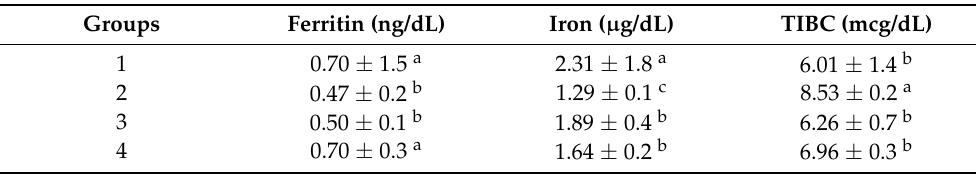
Table 1. Iron profile in lead-acetate-induced anemic rats treated with chemical or green biosynthe- sized magnetic iron oxide nanoparticles.